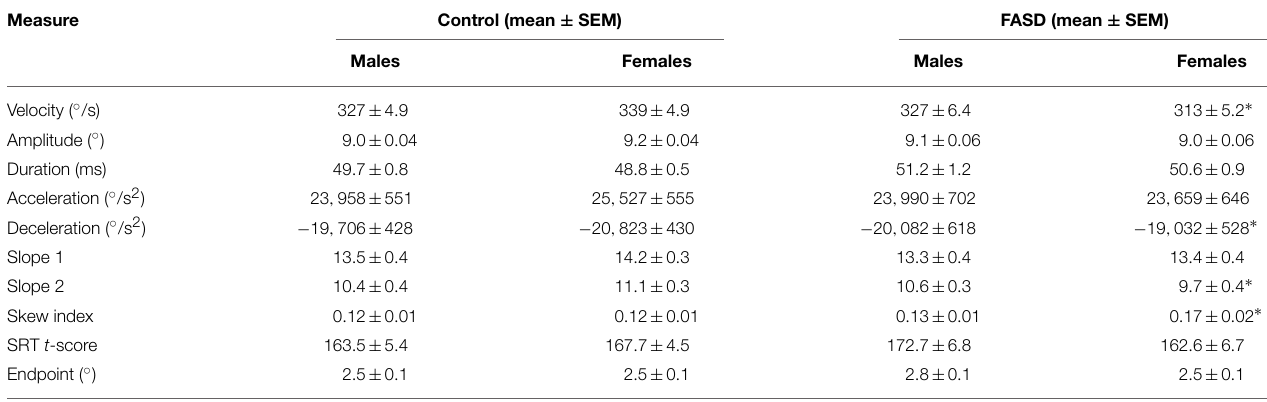
∗ Indicates significant difference from control